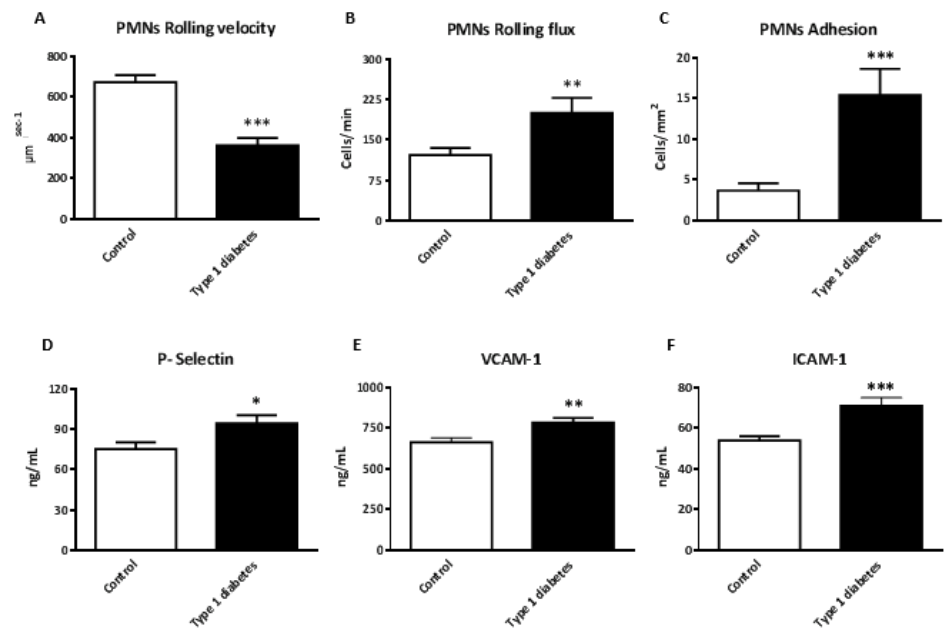
Figure 2. Evaluation of PMNs interactions in type 1 diabetic and control subjects, and levels of adhesion molecules in serum. ( A ) PMNs rolling velocity (μmsecond −1 ); ( B ) PMN rolling flux (cells/min); ( C ) PMNs adhesion (cells/mm 2 ); ( D ) Levels of P-selectin (ng/mL); ( E ) Levels of VCAM-1 (ng/mL); ( F ) Levels of ICAM-1 (ng/mL). Data are expressed as mean ± SEM. * p < 0.05, ** p < 0.01, *** p < 0.001 control vs. type 1 diabetic subjects. Abbreviations: ICAM-1: intercellular adhesion molecule-1; PMNs, polymorphonuclear leukocytes; P-selectin: platelet selectin; VCAM-1: vascular cell adhesion molecule-1.